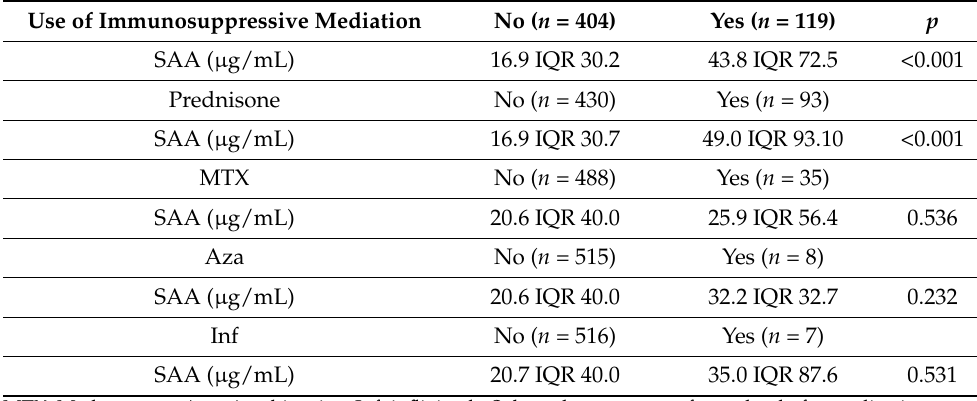
Table 3. Median SAA levels in Sarcoidosis, HP, and (E)GPA patients with and without immuno- suppressive medication.